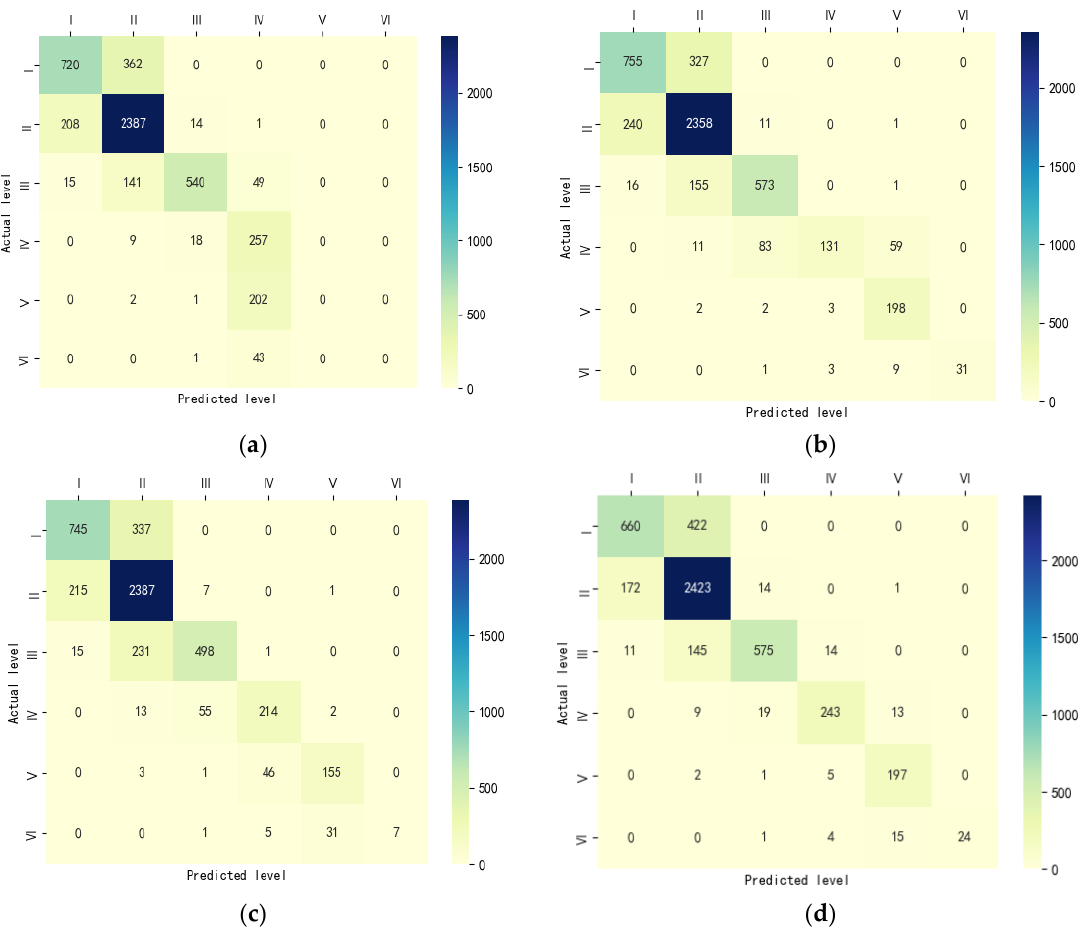
Figure 8. Statistical results of estimation levels for different models. ( a ) Statistical results of estimation levels for RF model; ( b ) statistical results of estimation levels for V-SVR model; ( c ) statistical results of estimation levels for Seasonal BLS model; ( d ) statistical results of estimation levels for CART – BLS model.